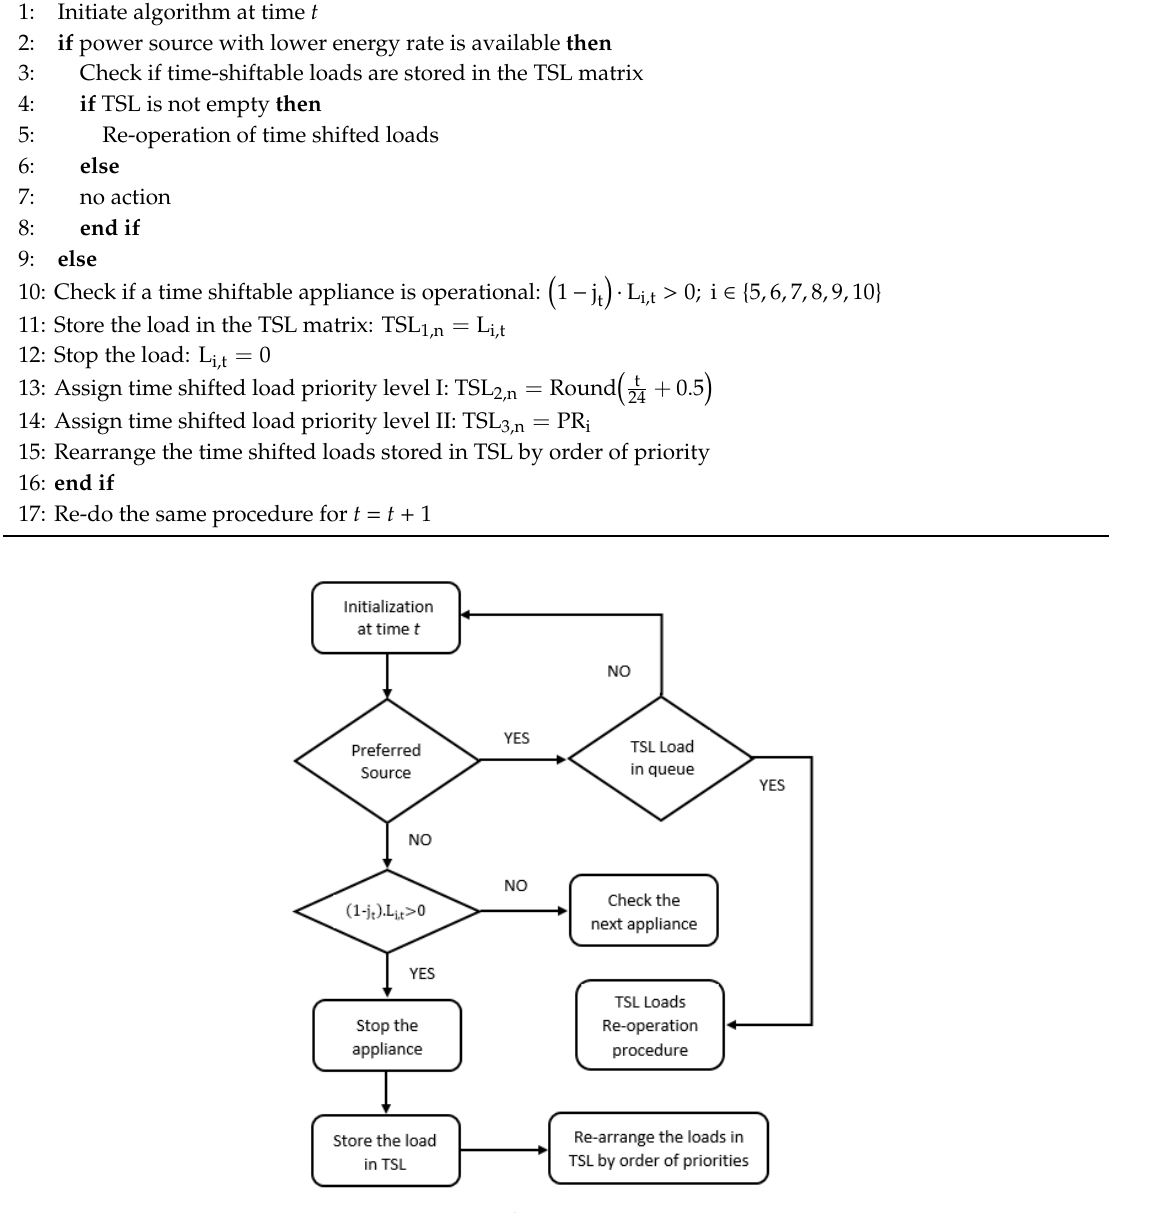
Figure 3. Demand Response Logic Diagram.